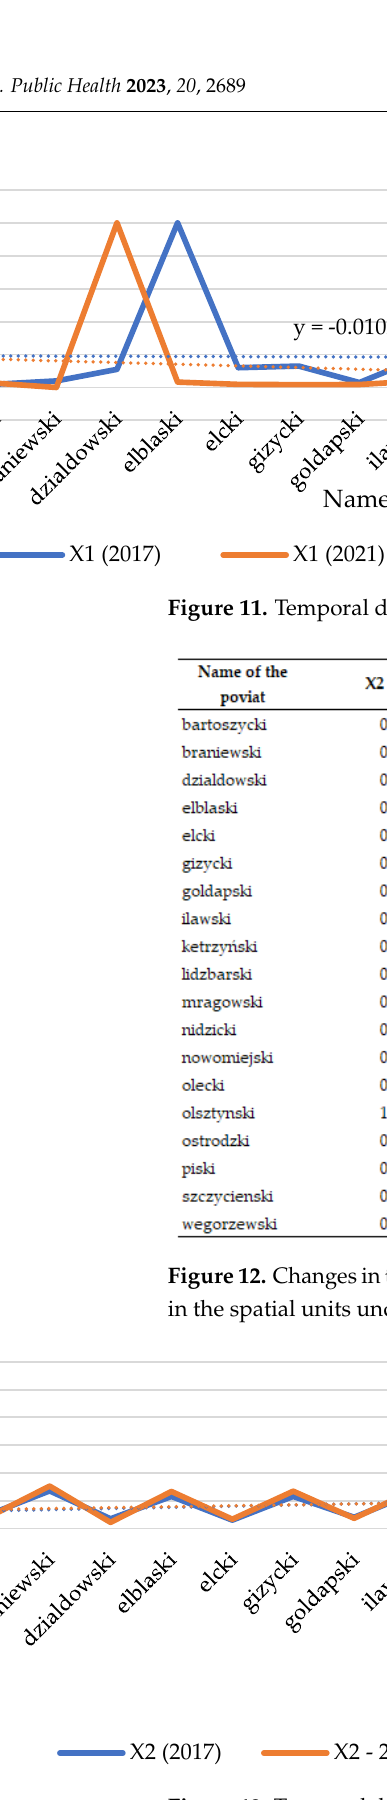
Figure 13. Temporal dynamics of the number of extreme weather phenomena and weather anomalies (X2). Source: own